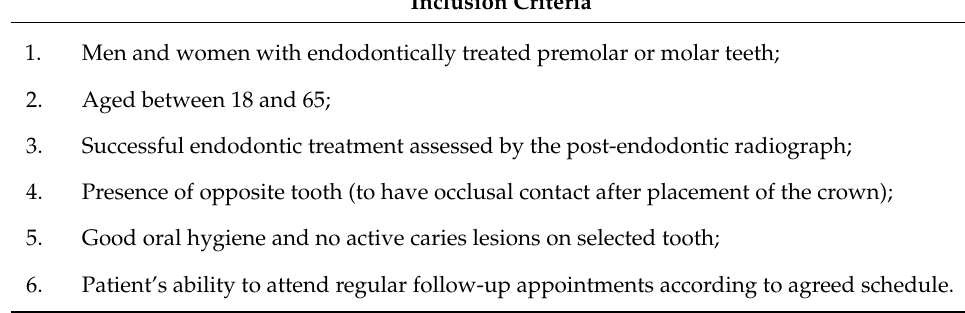
Table 1. Inclusion